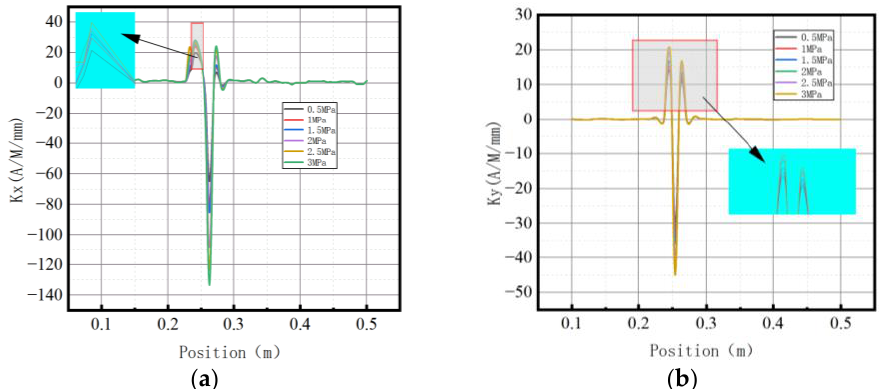
Figure 19. Magnetic signal gradient K at base metal crack changes with internal pressures. ( a ) The axial gradient component Kx; ( b ) the radial gradient component Ky.